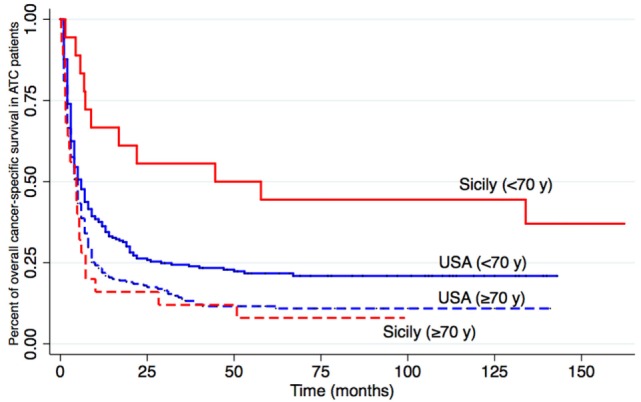
Overall cancer-specific survival. Kaplan–Meier causes for cancer-related mortality in Sicily (The Sicilian Regional Register for Thyroid Cancers, red) and USA (Surveillance Epidemiology and End Results, blue). Anaplastic thyroid cancer patients are subdivided according to age (<70 or ≥70 years) at diagnosis. The log-rank p-value is significant (0.02) for the difference in younger patients (<70 years) but not older ones (0.28).